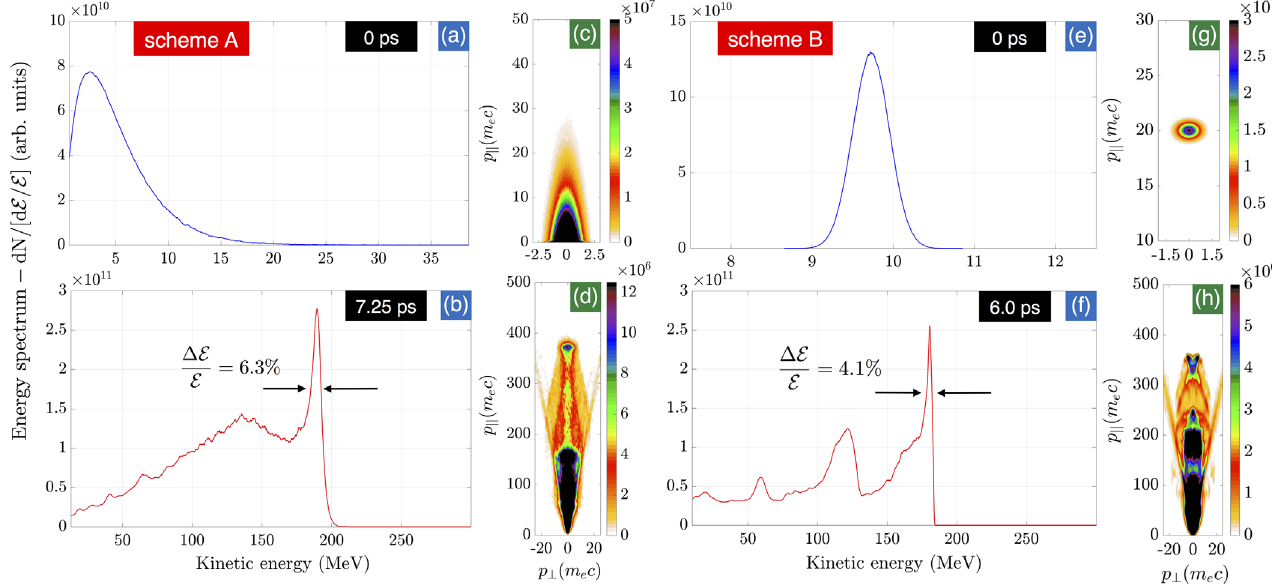
FIG. 2. Energy spectra and p ⊥ − p k phase-spaces of e þ -LPA accelerated e þ -beams modeled with n 0 ¼ 10 18 cm − 3 using a 50 fs laser with a 0 ¼ 1 . 4 and Full Width at Half Maximum (FWHM) spot-size of 40 μ m. For Scheme A (Scheme B), the initial conditions are in (a),(c) [(e),(g)] and the e þ -beam at 2.2 mm (1.8 mm) in (b),(d)